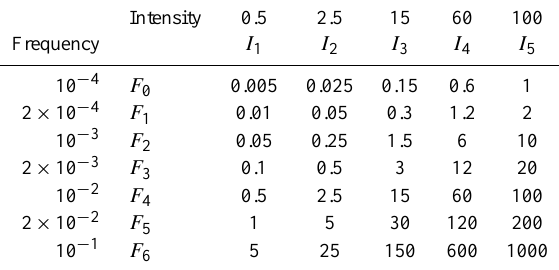
Table 4. Threat matrix obtained crossing intensity and frequency baselines; values indicate possible thresholds for